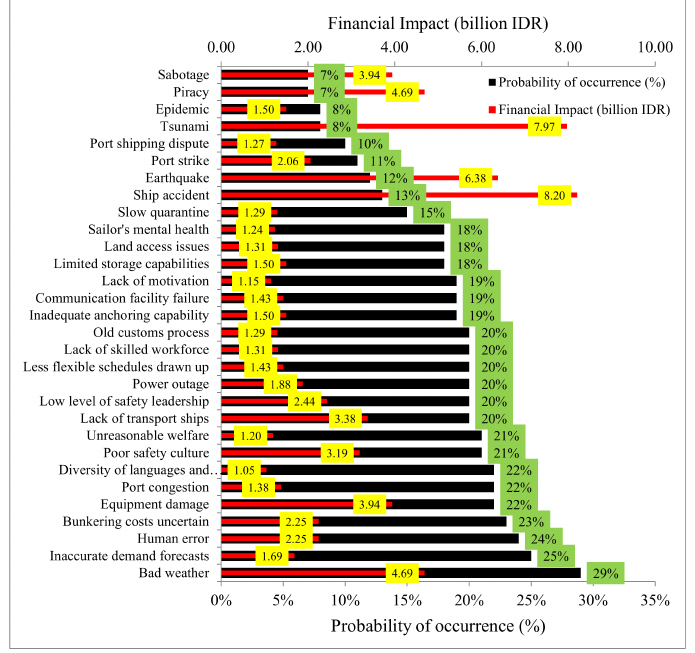
Figure 6. Probability and financial impact of SS-LNG supply chain risks in Indonesia.